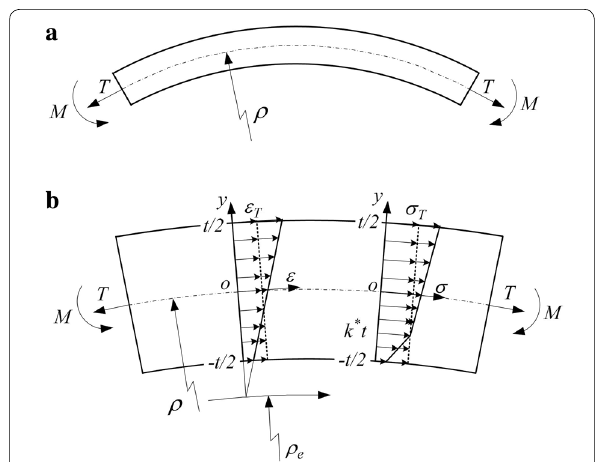
Figure 5 Analytical model of V-free